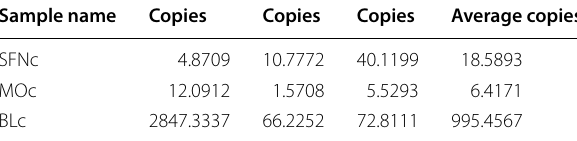
Table 1 Quantitative analysis results of